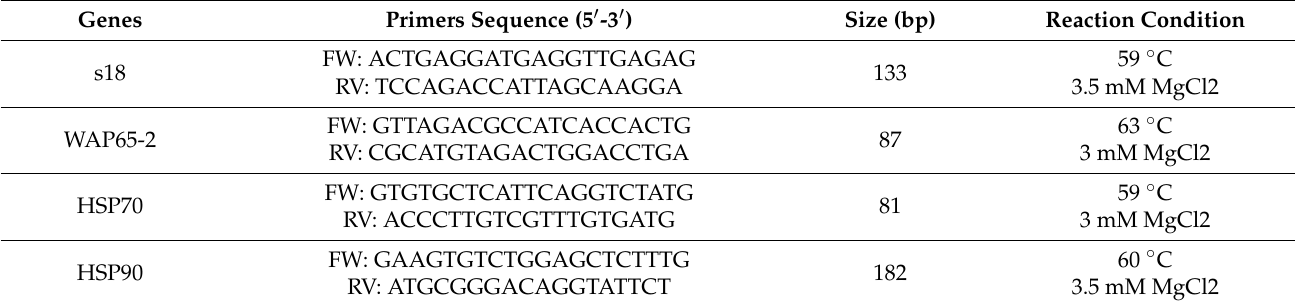
Table 1. Primers and reaction conditions used in the